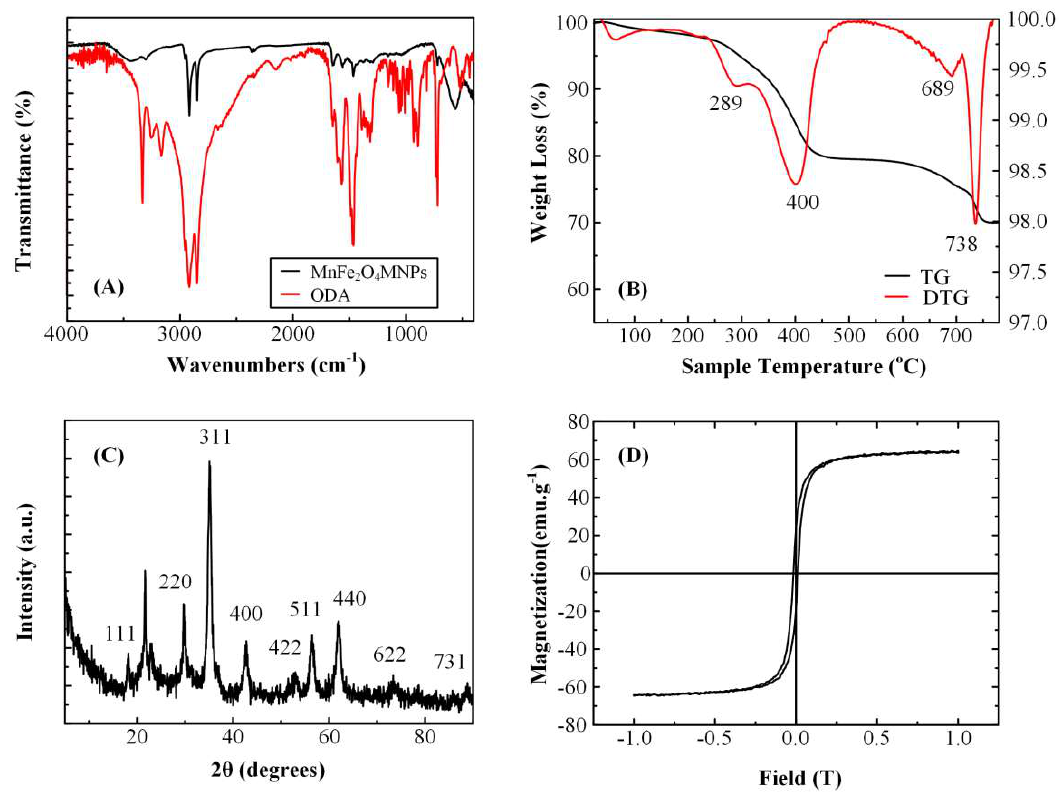
Figure 4. FTIR spectra ( A ), TG and DTG curves ( B ), XRD pattern ( C ), and VSM measurements ( D ) of MnFe 2 O 4 MNPs.